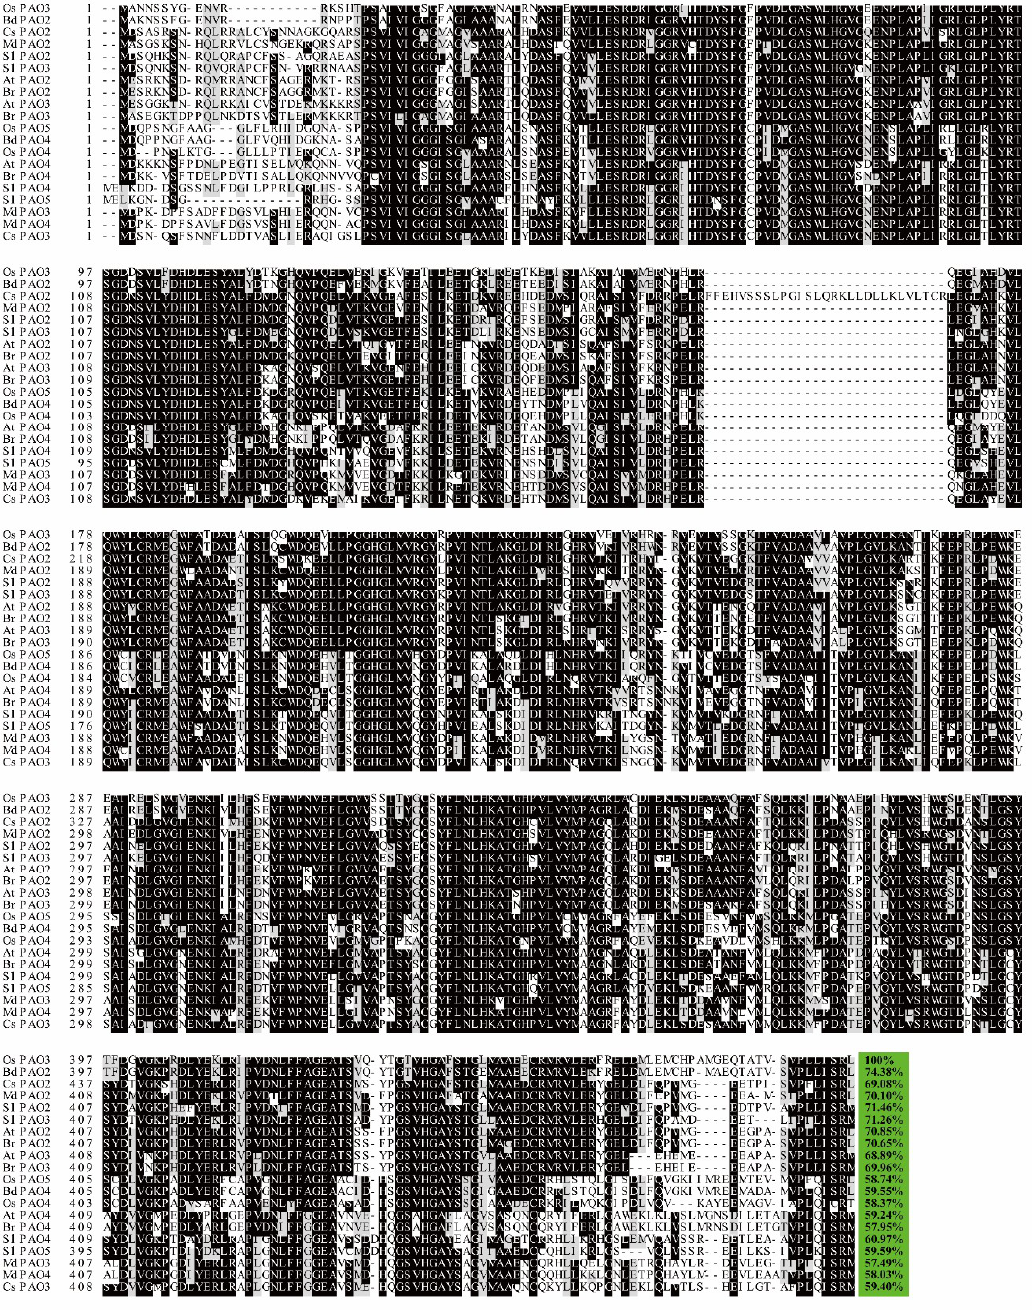
Figure 3. Alignment of amino acid sequences of twenty reported peroxisomal PAOs from Oryza sativa , Arabidopsis thaliana , Solanum lycopersicum , Brachypodium distachyon , Brassica rapa , Citrus sinensis, and Malus domestica . The alignment was performed by the Clustal X 1.83 software and exhibited by the Boxshade program (http://www.ch.embnet.org/software/BOX_form.html.). Black and gray indicate the complete and partial homology of the amino acid sequences, respectively. The percentages at the end of the alignment showed the identity between OsPAO3 and other PAOs.